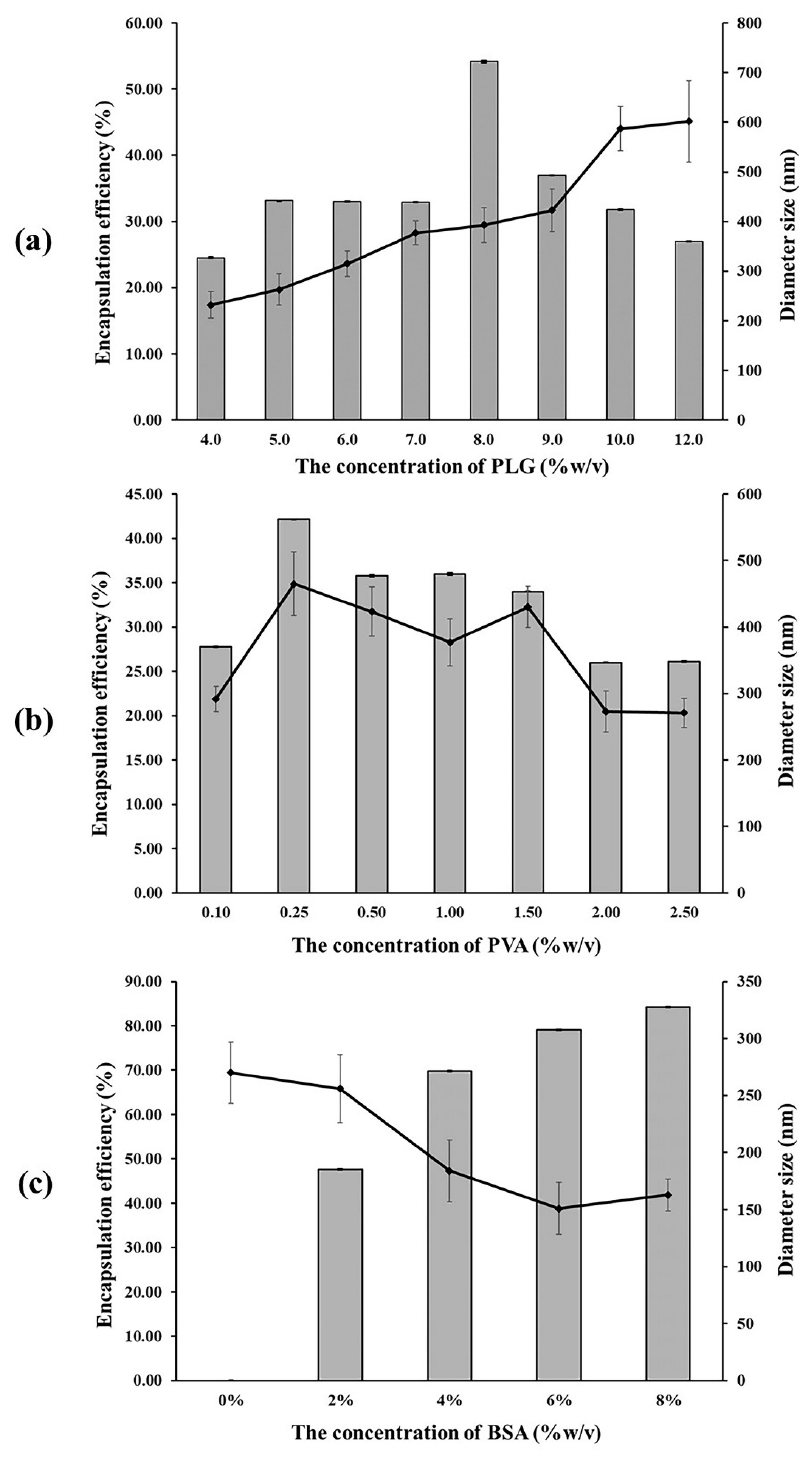
Figure 1. Encapsulation efficiency (%) ( ) and diameter size (nm) ( - - ) of the BSA encapsulated in the PLG microparticles with various concentrations of ( a ) PLG, ( b ) PVA, and ( c ) BSA (% w / v ).